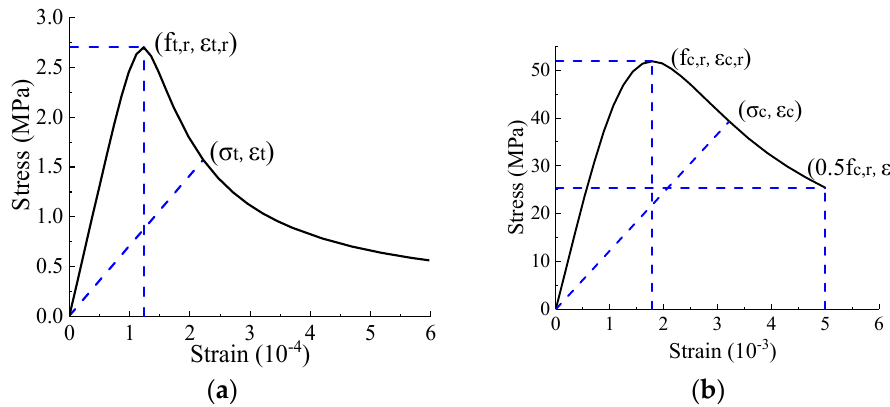
Figure 15. Stress–strain curve for concrete. ( a ) Tensile stress; ( b ) compressive stress. E c : Elasticity modulus of concrete.